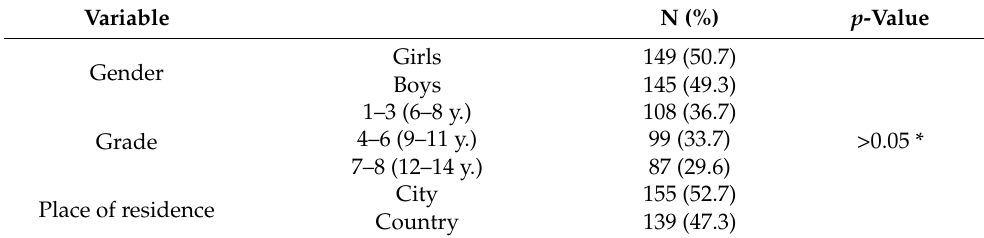
Table 1. Characteristics of the study group (N = 294).